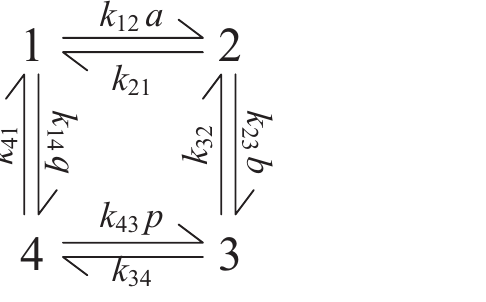
Figure 1. Basic compulsory-order ternary-complex mechanism. The basic ordered mechanism for the general reaction A z B ' P z Q , with a =[A], b =[B], p =[P], and q =[Q] is illustrated. The four states refer to unbound enzyme (state 1), enzyme-substrate A complex (E ? A, state 2), enzyme-substrate A-substrate B complex (E ? AB, state 3), and enzyme-product Q complex (E ? Q, state 4). The four steps of the catalytic cycle are detailed in Equation (1).